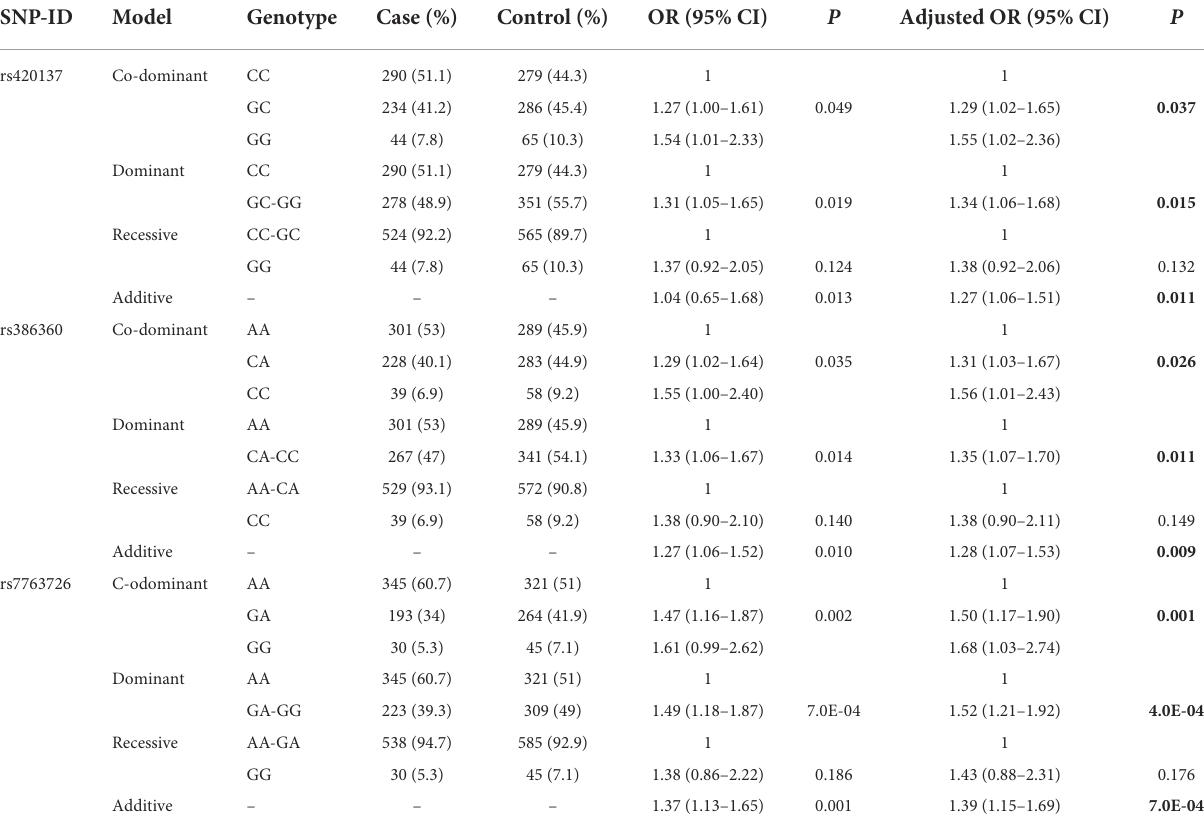
Table 4 also shows that rs386360 had a higher risk of CHD under the co-dominant, recessive, and additive models ( p = 0.027, 0.044, and 0.030, respectively) in patients aged ≤ 62